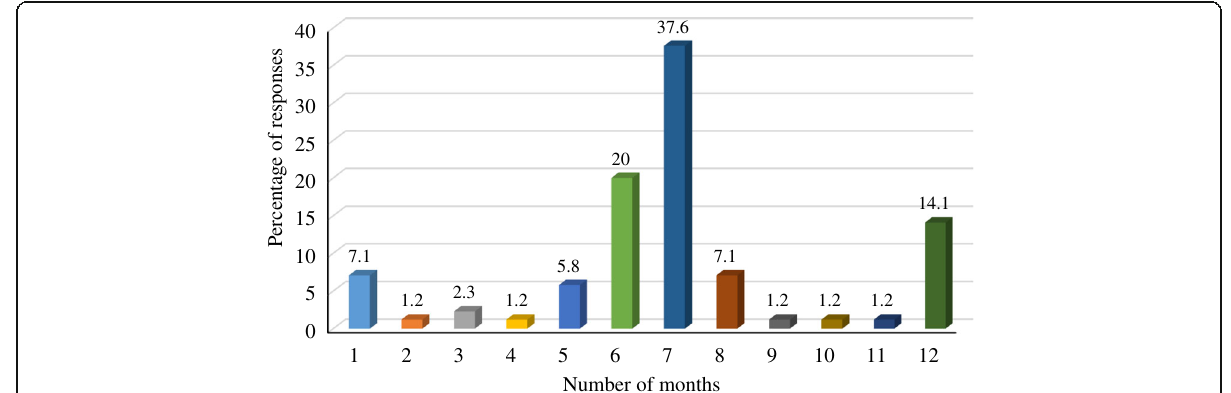
Fig. 2 Farmers ’ perception of the period of infestation of the Kersting ’ s groundnut by insect pests